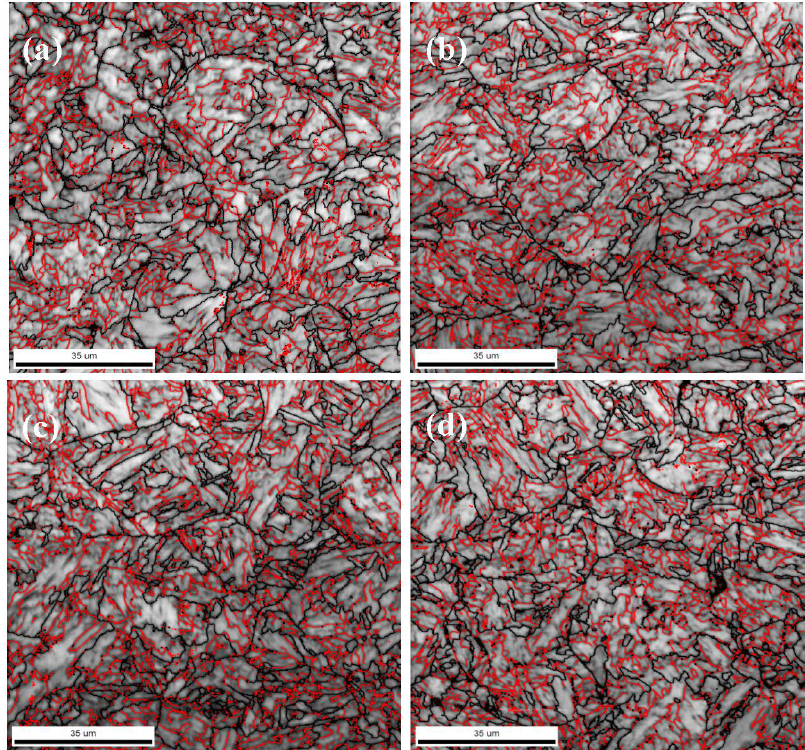
Figure 8. EBSD orientation maps of samples with varied cooling rates: ( a ) 5 ◦ C/s; ( b ) 10 ◦ C/s; ( c ) 15 ◦ C/s; and ( d ) 20 ◦ C/s. The red line and the black line represent the misorientation angle in the range 2 ◦ –15 ◦ and greater than 15 ◦ ,